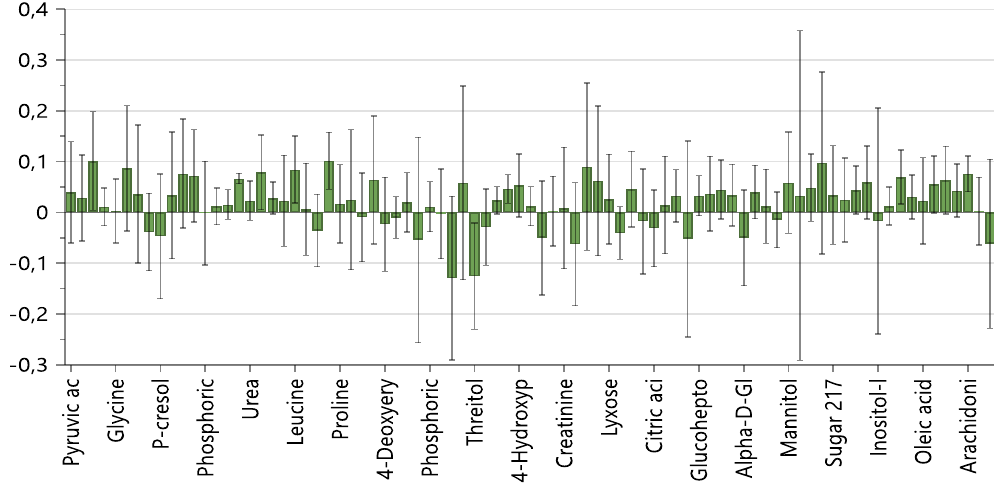
Figure 3. Contribution Plot of the PLS-DA showing the relative importance of metabolites in the clustering of the two Groups. Positive values: OHCM. Negative values: